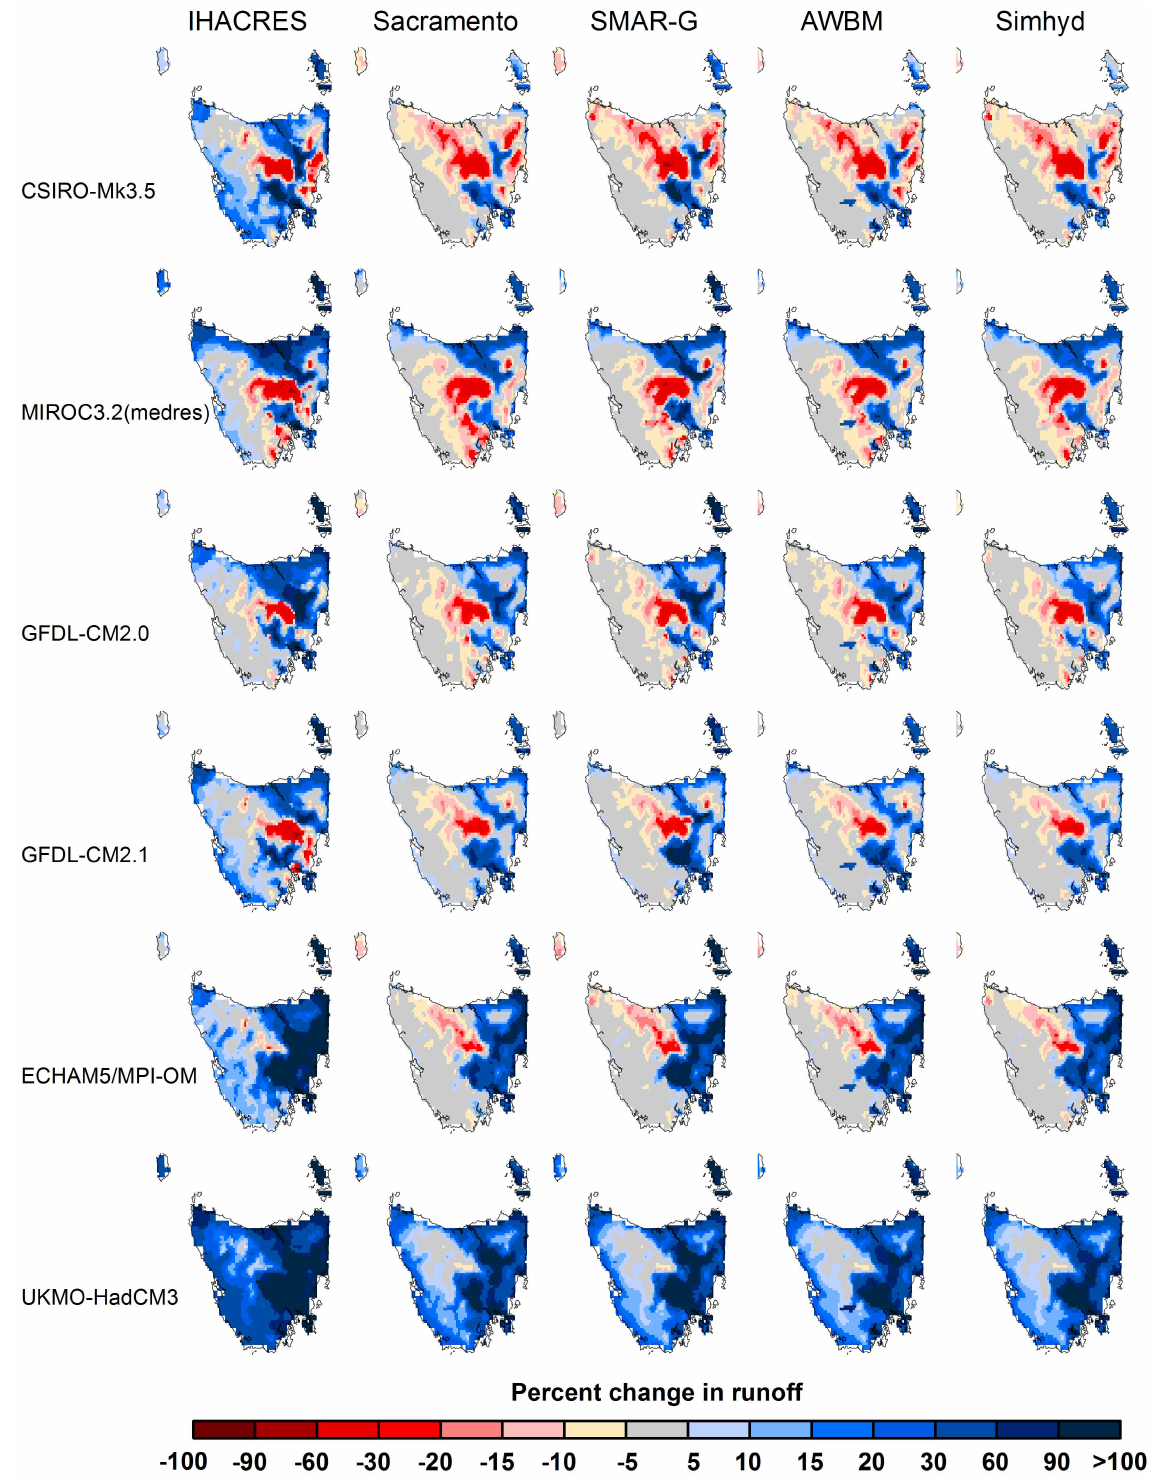
Fig. 11. Change in mean annual runoff from 1961–1990 to 2070–2099 for all RCM simulations and hydrological models. RCM simulations are designated by the GCMs used for downscaling, and are ordered from driest projection (CSIRO-Mk3.5, top) to wettest projection (UKMO- HadCM3, bottom). Hydrological models are ordered from most biased (IHACRES, left) to least biased (SIMHYD,